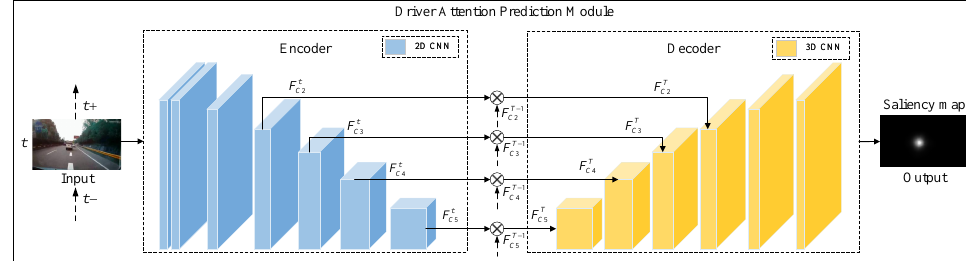
Figure 3. The overall Driver Attention Prediction Module, where t denotes the current frame, t − denotes the historical frame, t + denotes the future frame, and T = { t − T + 1,..., t } denotes the